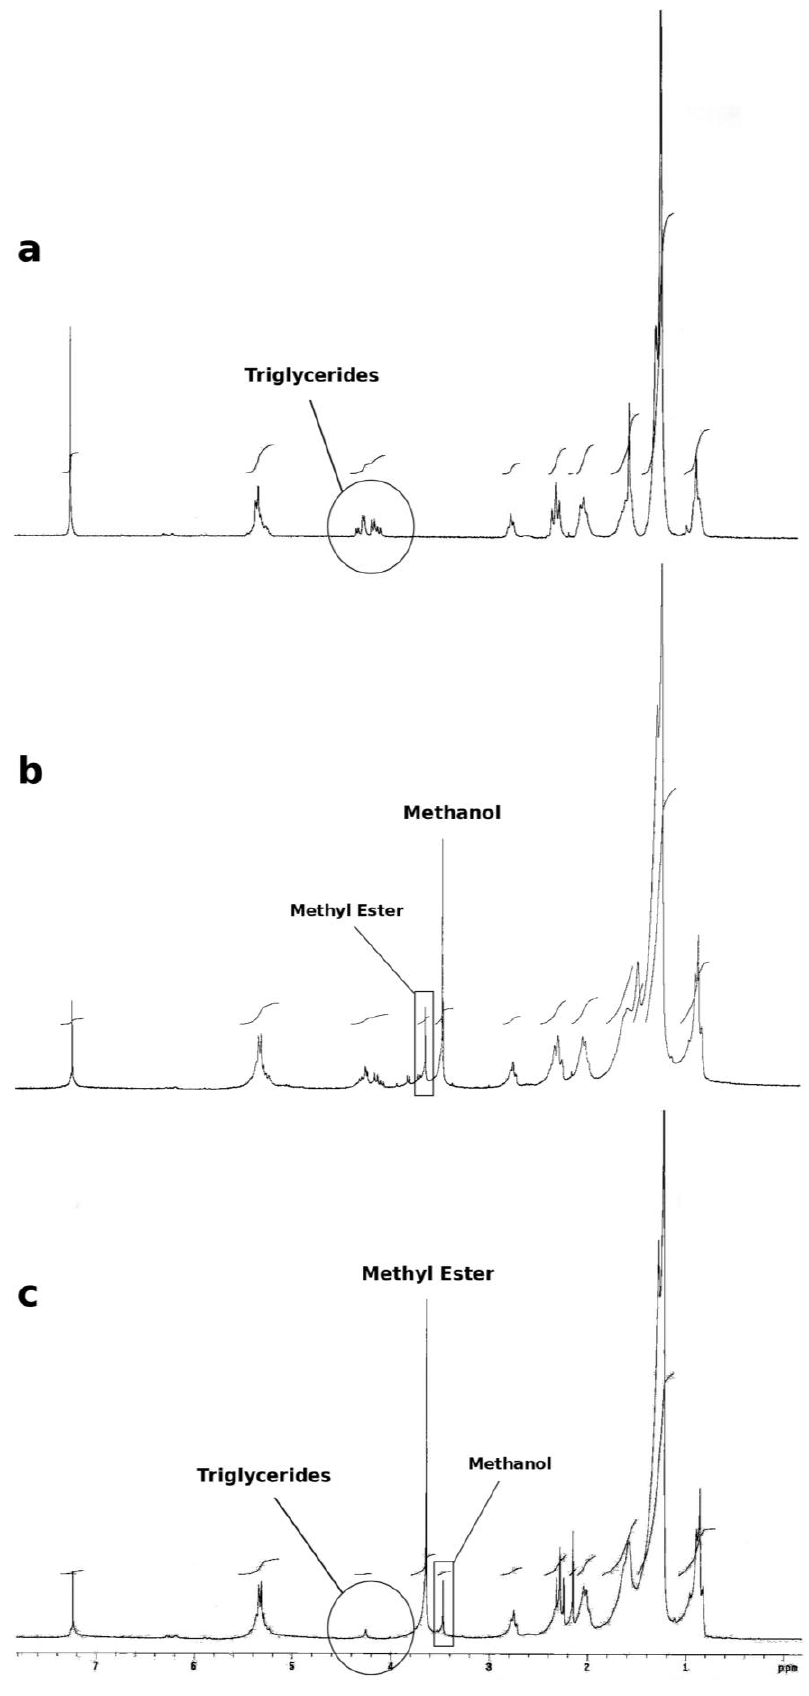
Figure 9. H 1 -NMR spectra of the oil from espresso spent coffee ground ( a ) and of the reaction mixture after 5 h ( b ) and 24 h ( c